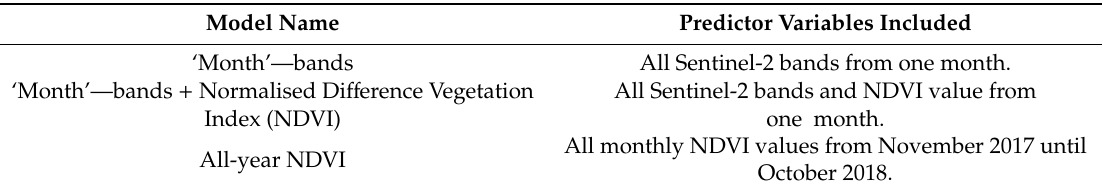
Table 1. Predictor variables used for the Partial Least Squares Regression (PLSR) and the Random Forest regression for Ethiopia and Tanzania separately.